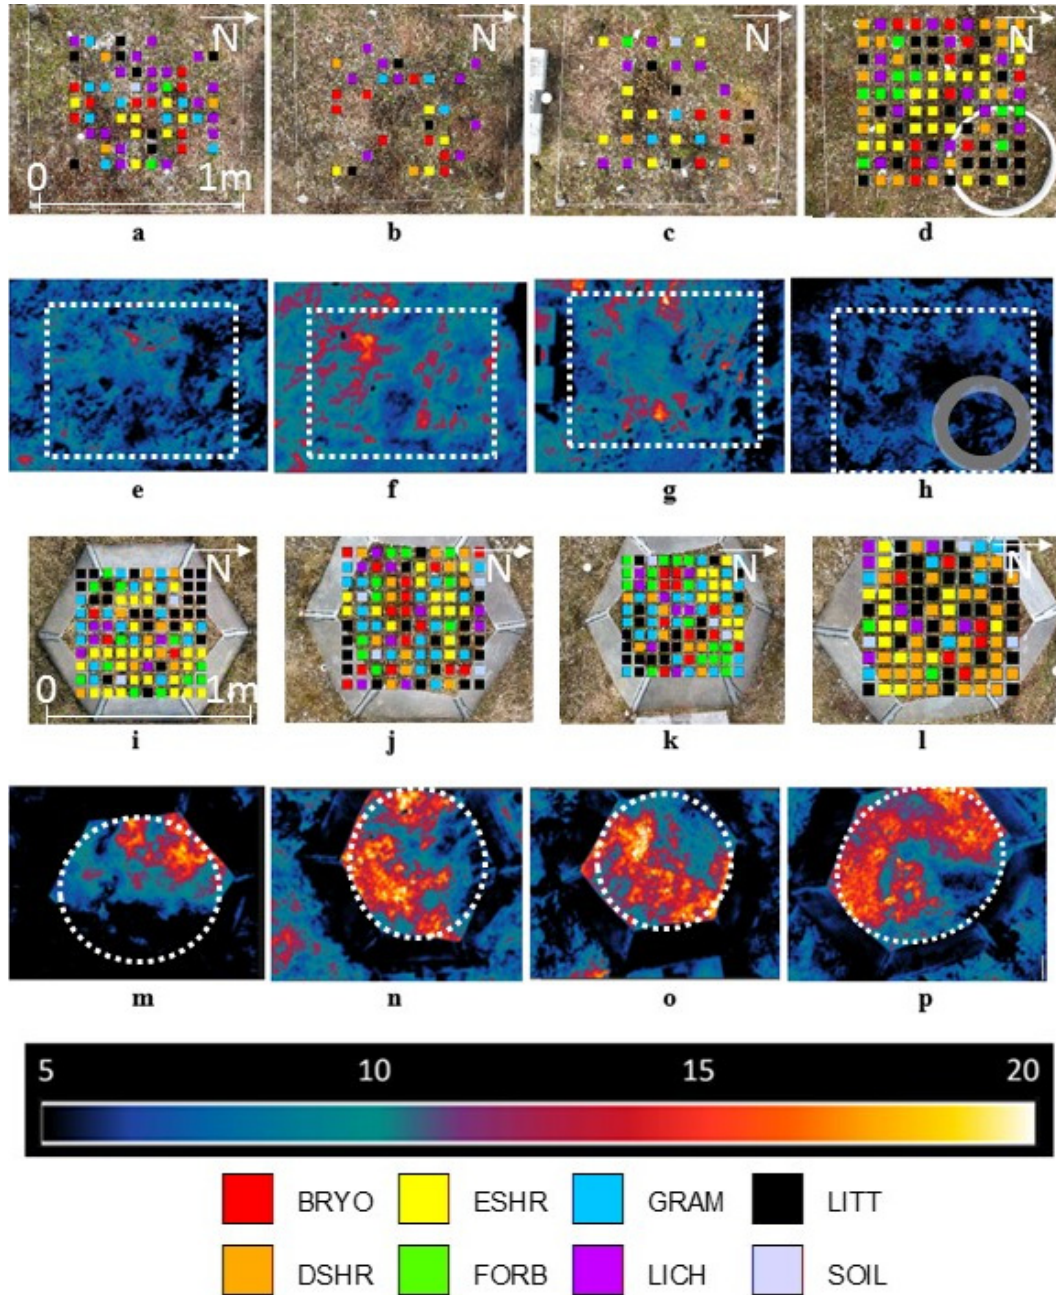
Figure 3. Images depicting four Barrow dry site plots ( a – d ) and the coinciding thermal images below ( e – h ); and images of four additional plots ( i – l ) with coinciding thermal images below ( m – p ). Note: the ring appearing in panels ( d , h ) is gas exchange collar not related to this study. Areas of image analysis are outlined with dotted white lines. Data within the transparent circular area has been removed. All temperatures are in degrees Celsius. Plant growth forms and surface features are depicted with the following abbreviations—BRYO: bryophyte/moss; DSHR: deciduous shrub; ESHR: evergreen shrub; FORB: forb; GRAM: graminoid; LICH: lichen; LITT: leaf litter; SOIL: bare soil/rock.